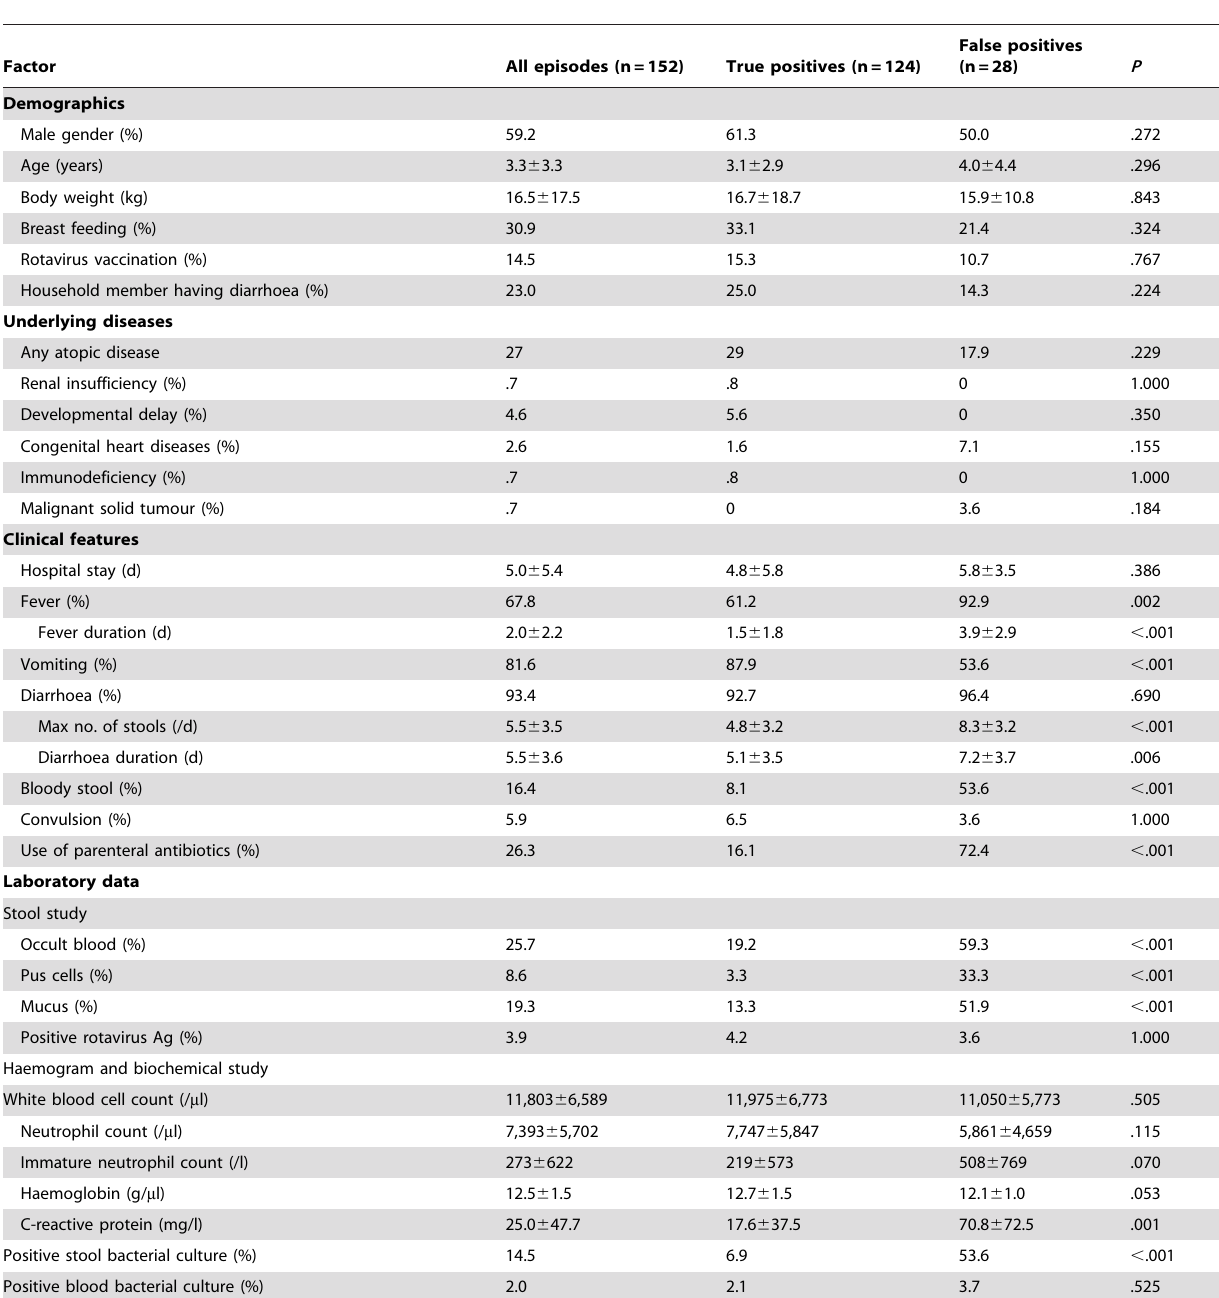
Table 1. Univariate analysis of the demographics and clinical parameters associated with false-positive results in the laboratory diagnosis of norovirus infections using RT-PCR targeting the RdRp